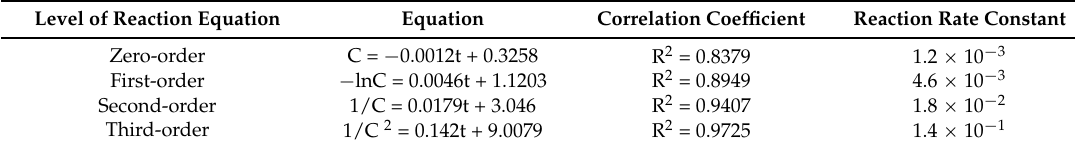
Equation of reaction kinetics for multiple micro-electrolysis degrading COD of oil refinery wastewater.